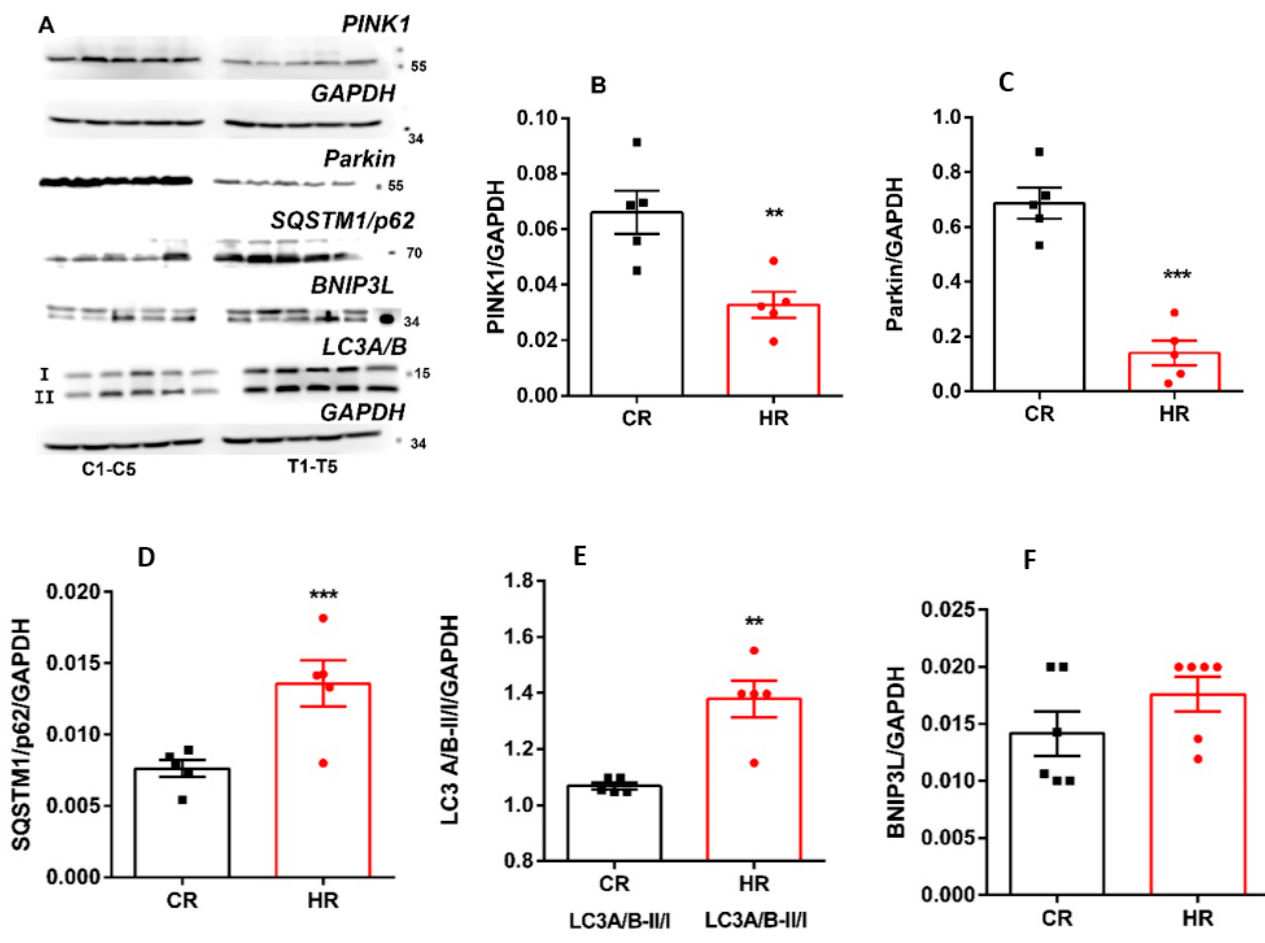
Figure 6. Immunoblotting analysis of mitophagy proteins in liver tissue of control and hyperthyroid rats. ( A ) Representative Western blot of Parkin, PINK1, SQSTM1/p62, LC3A/B-I:II, BNIP3L, C 1 -C 5 -CR, T 1 -T 5 -HR. ( B – F ) Relative levels of appropriate proteins with respect to the loading control (GAPDH). CR, control; HR, hyperthyroidism. *— p < 0.05, **— p < 0.02, ***— p < 0.001 as compared with the control data ( n = 5–6).